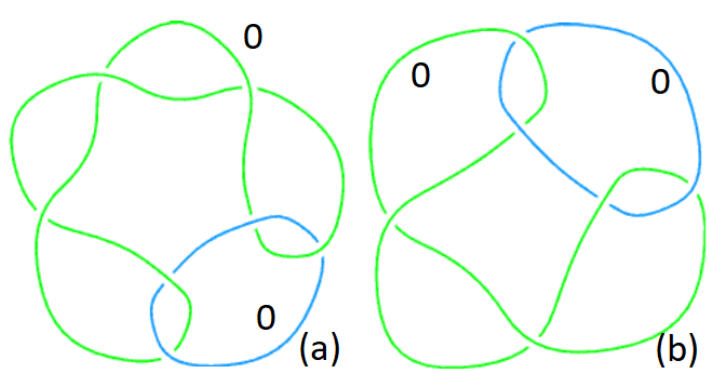
Figure 2. The 0-surgery on both pieces of links L7a4 in ( a ) and L6a1 in ( b ). The Groebner base for the corresponding character varieties contains the surfaces κ 2 ( x , y , z ) and κ 4 ( x , y , z ) for the former case, and κ 3 ( x , y , z ) for the latter